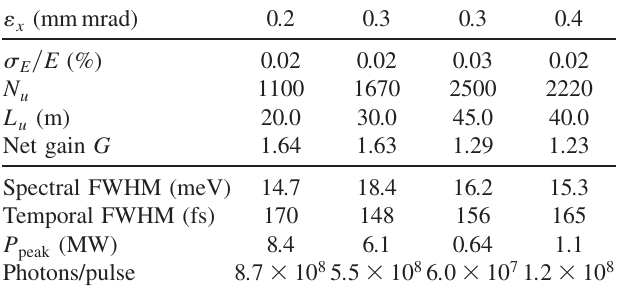
TABLE II. Electron beam, undulator, and output radiation parameters for the 100 fs, 100 A operation at 1 A˚ . For net gain and our definition of the gain G and total reflectivity R , we require R ð 1 þ G Þ > 1 ; the parameters listed assume R ¼ 0 : 5 . The multiple reflections from the crystal surfaces lead to a sequence of low-amplitude pulses, as shown in Fig. 9, although the first, main pulse is nearly Gaussian. Note that these oscil- lations follow the main pulse, so that the leading, main pulse has a high contrast ratio with minimal prepulse